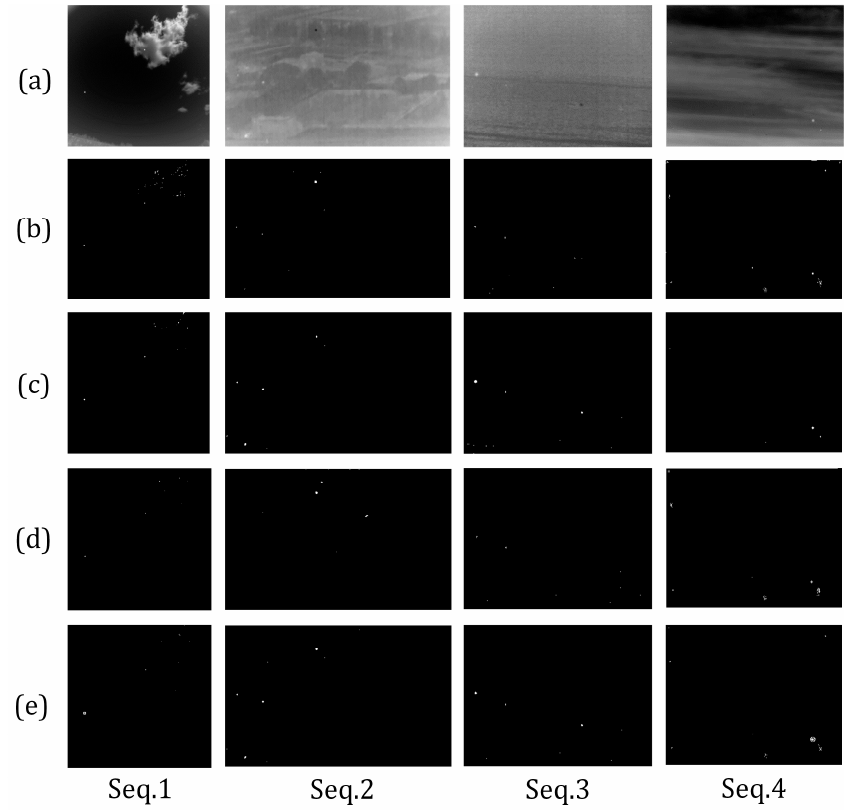
Figure 10. Binarized results of in-frame detection via Otsu’s method: ( a ) Raw IR images; ( b ) Max-Mean; ( c ) BHP; ( d ) Hat; ( e ) TDLMS.